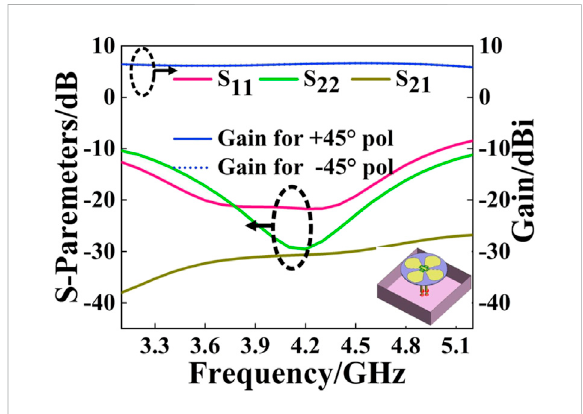
FIGURE 3 Simulated results of the feed antenna.